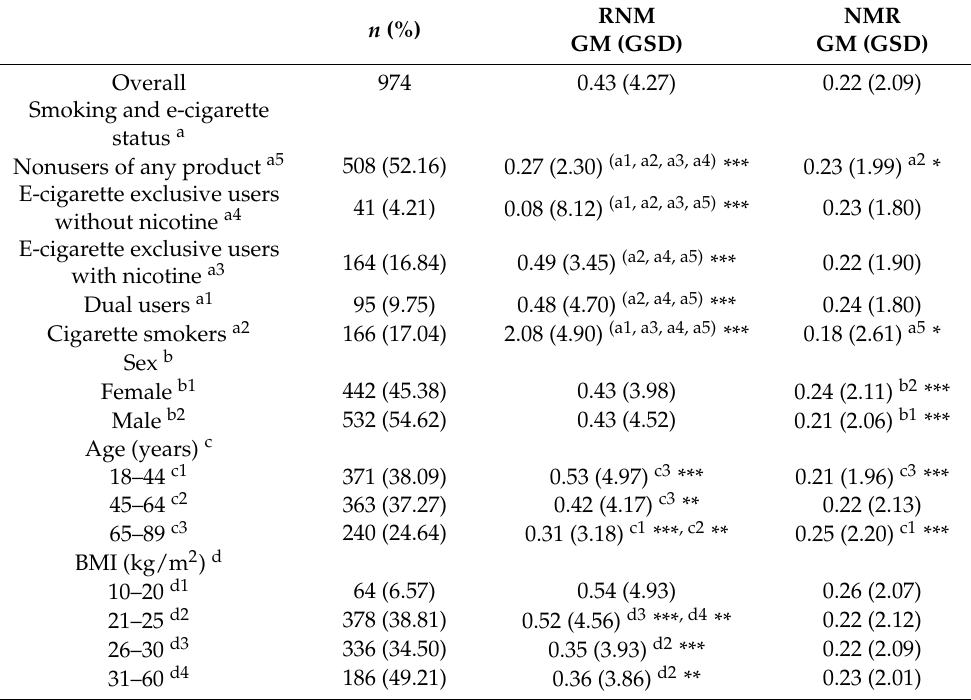
Table 1. Geometric mean (GM) and Geometric Standard Deviation (GSD) of Rate of Nicotine Metabolism (RNM) and Nicotine Metabolite Ratio (NMR) in saliva samples according to smoking status and use of e-cigarette, sex, age and body mass index